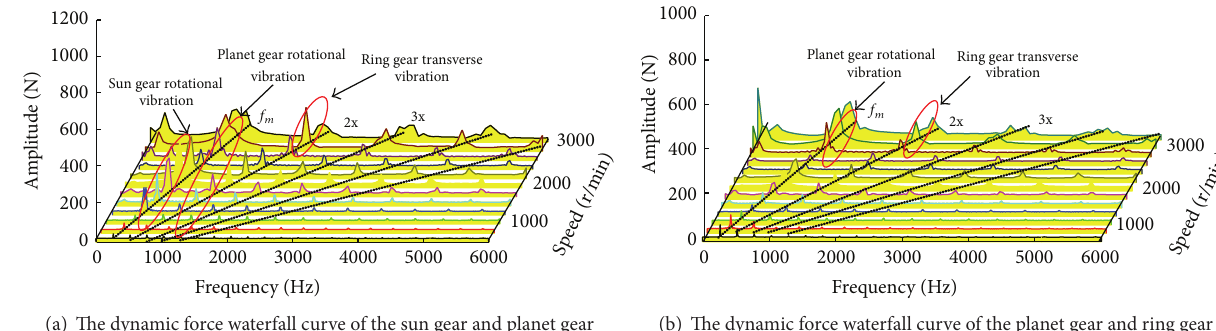
Figure 7: The dynamic force waterfall curve of the sun gear and planet gear.